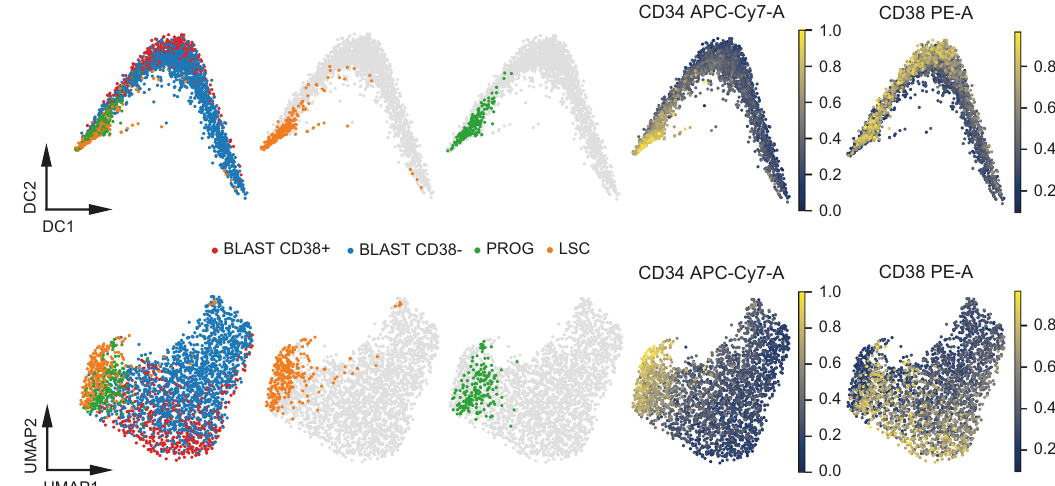
Fig. 7 Integration of unbalanced scMS datasets. Diffusion map and UMAP embedding of integrated dataset (2514 cells, 917 proteins), overlaid with the FACS derived gated populations, CD34 and CD38 expression. BLAST = blasts, PROG = progenitors, LSC = leukemia stem cells. Source data are provided as a Source Data fi